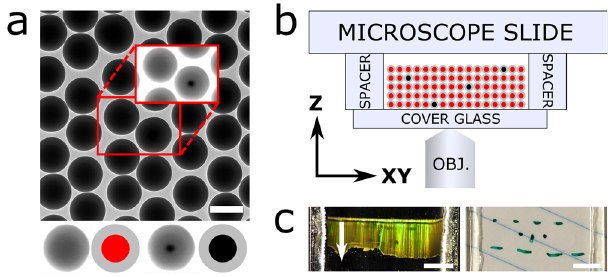
Fig. 1 Calibration and alignment sample. a Transmission electron micrograph (TEM) of the two building blocks of the sample: monodisperse silica-coated 45 nm fl uorescent silica (red) and 80 nm gold (black) cores with a total diameter of 505 nm. The bottom row depicts the fl uorescent (left two) and gold core (right two) particles, as imaged with TEM (left) and as schematic (right) as used in ( b ). The cores of the schematic particles are not drawn to scale. Inset: upon (TEM) contrast variation the gold cores become visible. The scale bar is 500 nm. b Schematic of the sample as seen from the side consisting of a crystal composed of the particles in ( a ). c Top view of the sample showing the bright Bragg re fl ections of the index matched crystal upon illumination from the side (left) and full transparency under available light (right). The green marking on the sample was used to locate the crystal after refractive index matching. The direction of crystal growth during vertical deposition is parallel to the Y direction, as indicated by the white arrow in ( c ). The scale bars are 0.5